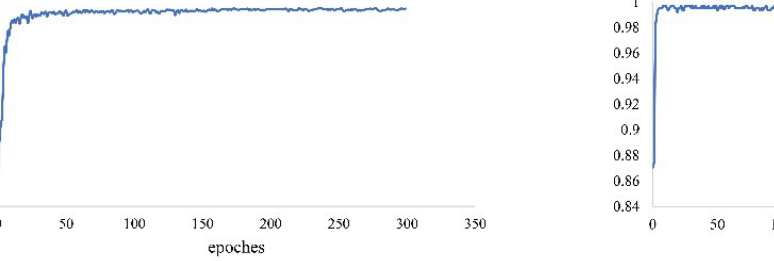
Figure 12. P-R curve. 4. Conclusions In this paper, a field pest identification method based on YOLOv5 and hyperspectral technology was proposed. The results have demonstrated that this method can effectively identify pests with protective color characteristics in the complex field environment. In the process of collecting pest images, to realize the identification of pests with pro- tective color characteristics, obtain the Pieris rapae and cabbage spectral information by